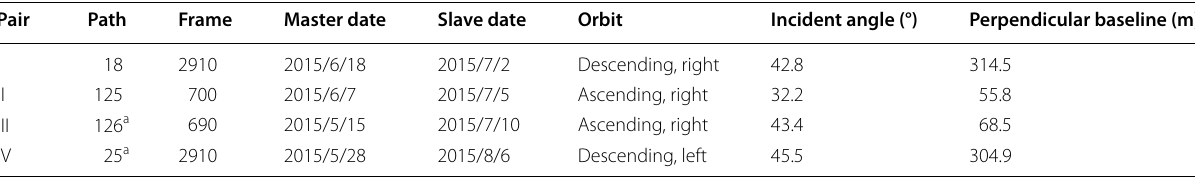
a Pairs III (Path 126) and IV (Path 25) were not used for the model inversion